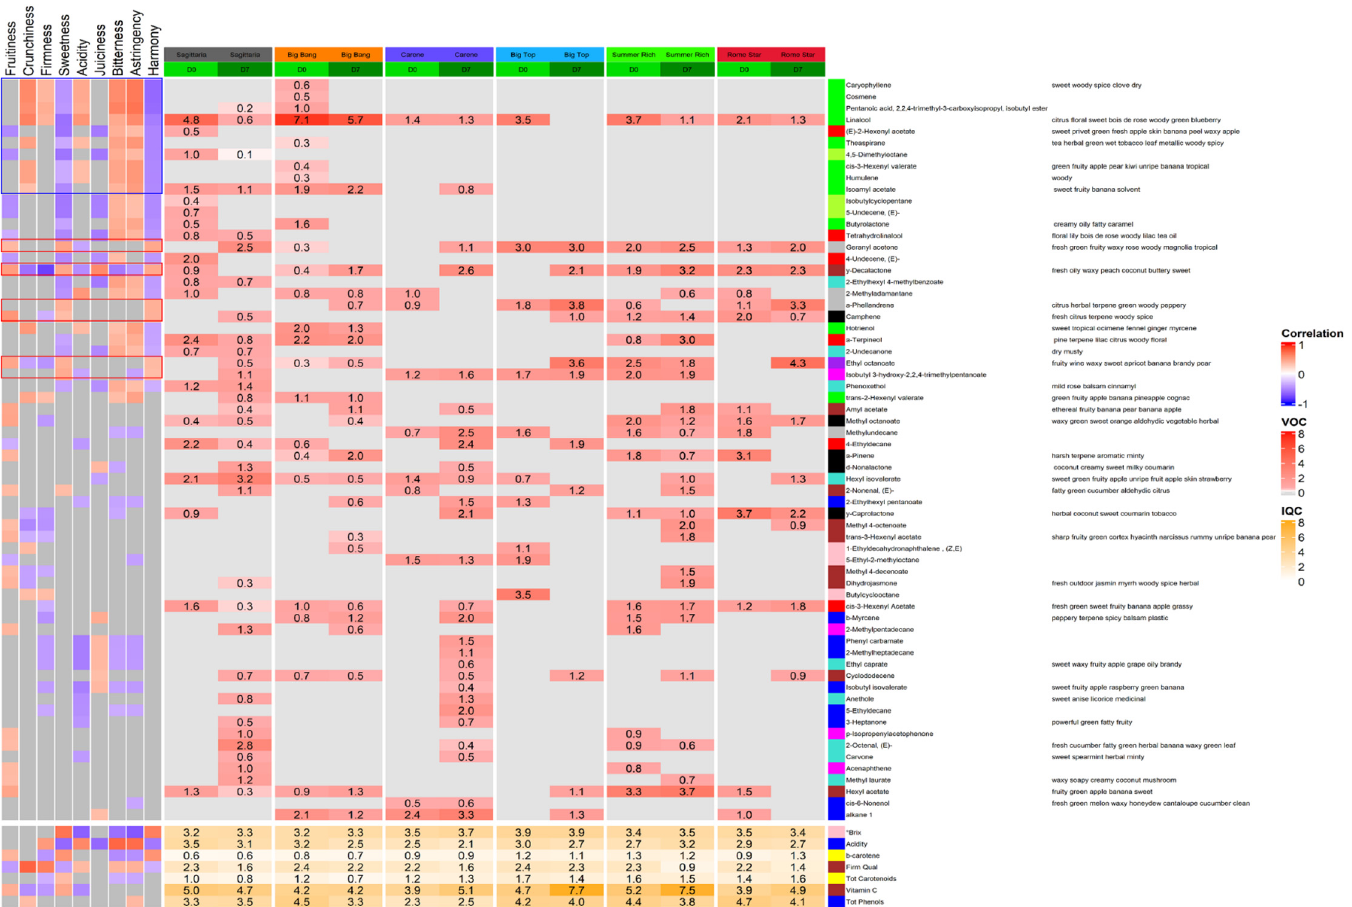
Figure 4. VOCs ( top ) and intrinsic quality parameters ( below ) significantly associated with at least one sensorial attribute, based on WCNA. Grey boxes in the main heatmap indicate that a compound was not detected in that cultivar/day combination. On the left heatmap, grey boxes indicate that a compound was not significantly correlated with that sensorial characteristic; the direction and strength of significant correlations are indicated by the coloured boxes. For VOCs, notes on odour are indicated to the right of each name. Numbers indicate square-root transformed mean relative abundances. Cultivars are shown in order of ripening.Blue box: top 10 VOCs negatively associated with harmony; red boxes: VOCs positively associated with harmony.